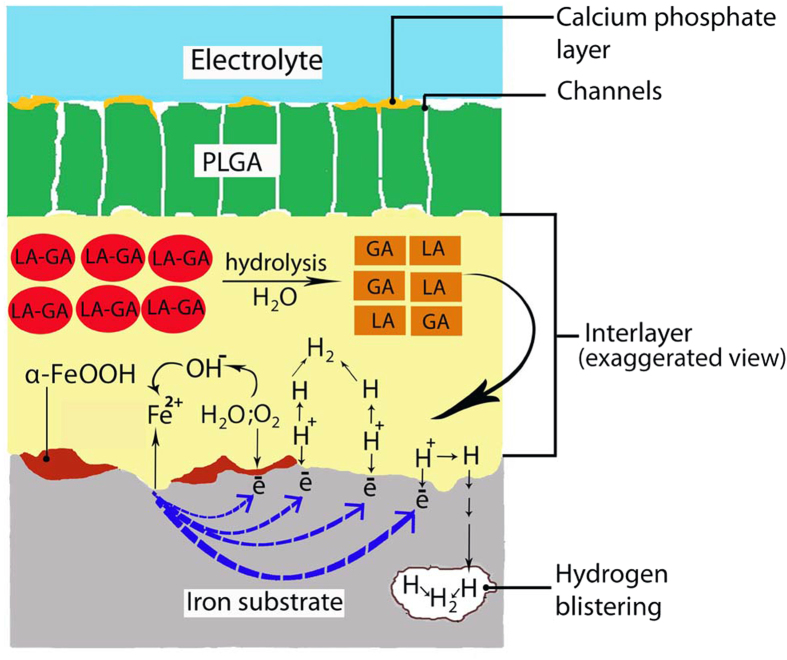
Proposed degradation mechanism at the iron/PLGA interface.